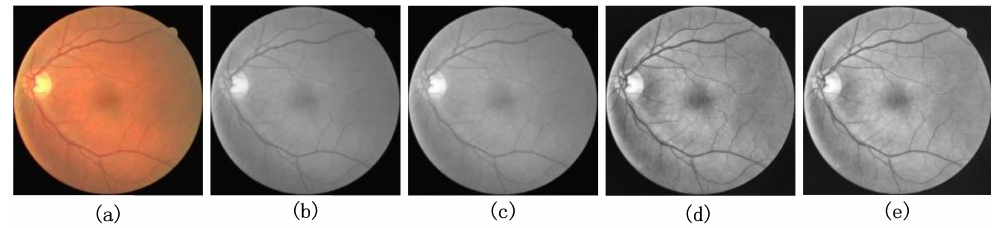
Figure 6. Example images of three datasets ( a ) original retinal fundus vessel medical image, ( b ) masked image, and ( c ) expert manual segmentation of the groundtruth.